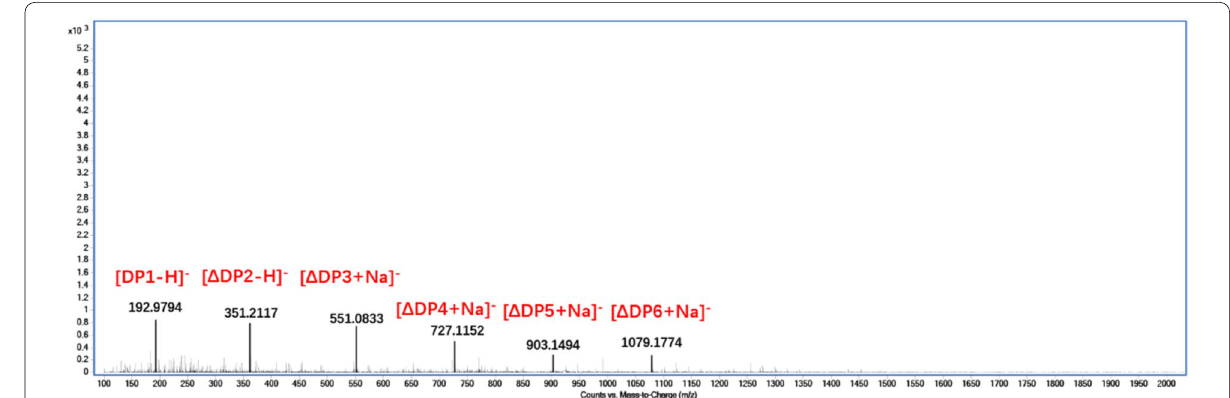
Fig. 8 ESI-MS analysis of the degradation products of ErPelPL1 towards polygalacturonic sodium. The mass-to-charge ratios ( m/z ) of oligosaccharide products were detected by using ESI-MS. ΔDP n ( n